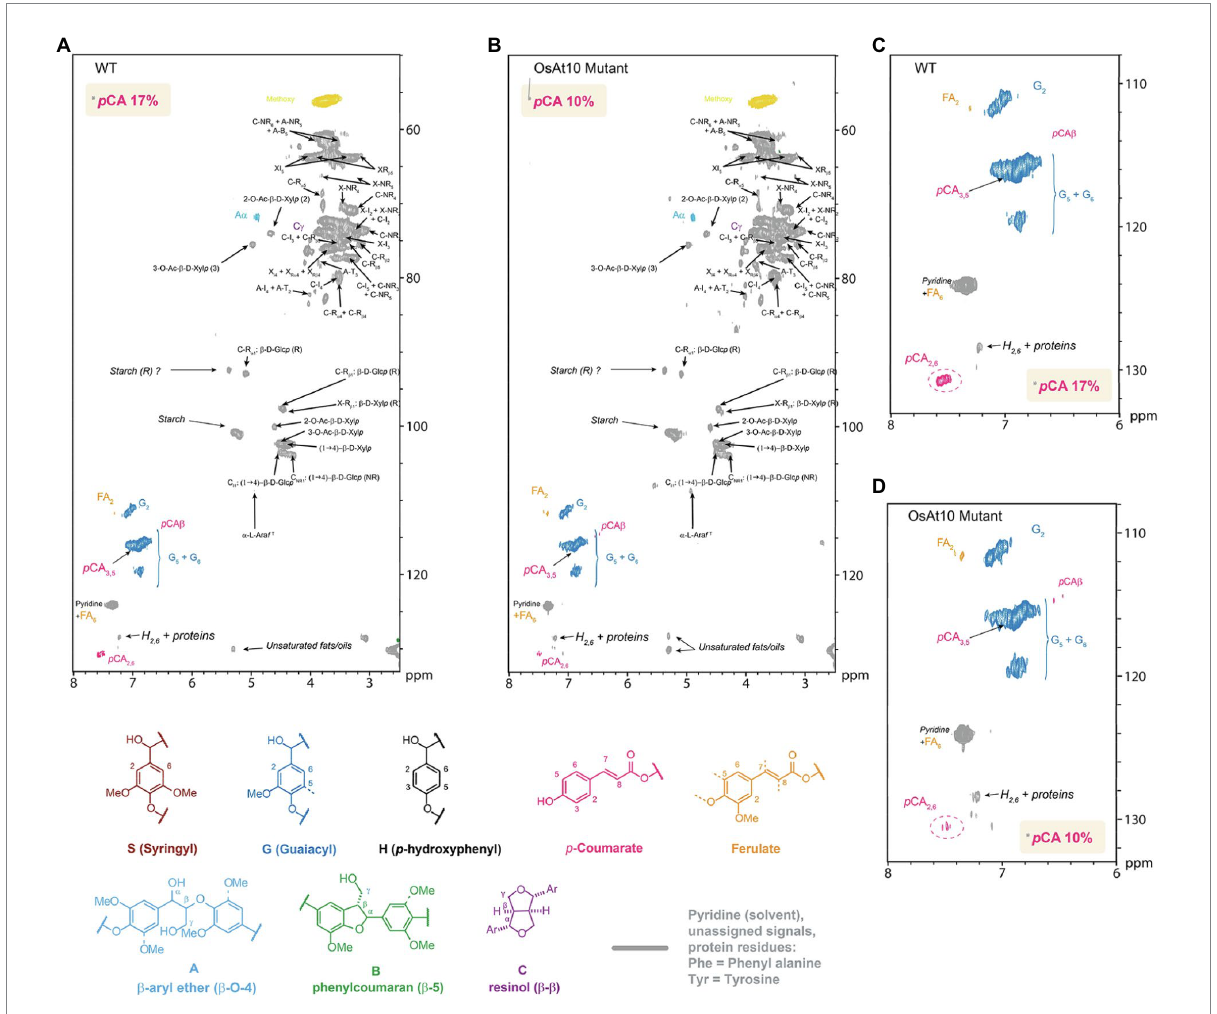
FIGURE 4 Whole cell gel-state 2D-NMR heteronuclear single-quantum coherence (HSQC) analysis of rice husk cell walls from (A–C) the WT control and (B–D) OsAt10 knockout mutant. The analytical data are from volume integrals of correlation peaks representing reasonably well-resolved C/H pairs in similar environments; thus, they are from G 2 and p-CA 2/6 in the aromatic region, with corrections applied for units that have two C/H pairs per unit. The p-CA 2/6 abundances are reported on a per 100 C9 unit basis relative to G = 100 C9 units. The small amounts of S units present in the samples were too low to be accurately quantified in these